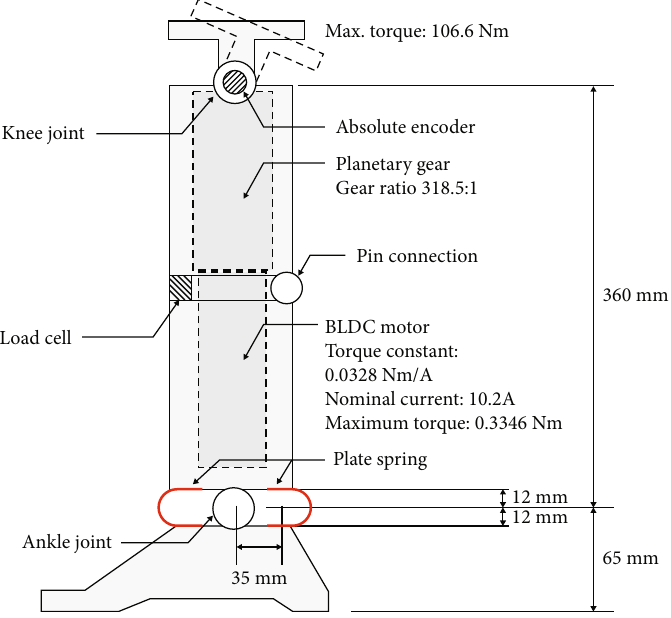
Figure 2: Concept modeling of a powered transfemoral prosthetic leg.